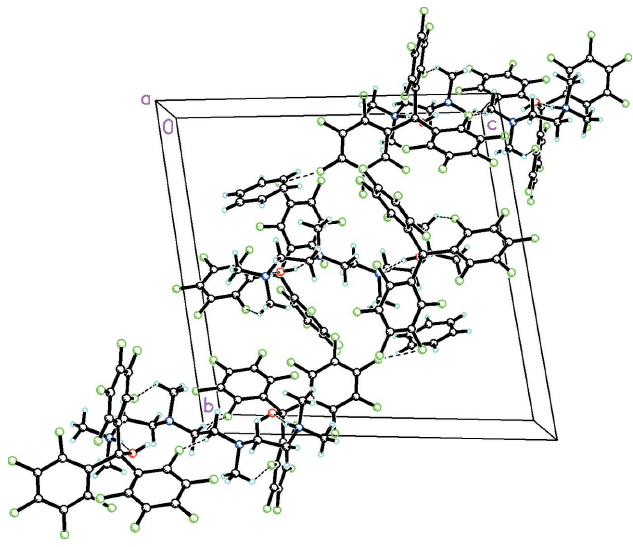
Figure 5 Packing diagram of the title compound.